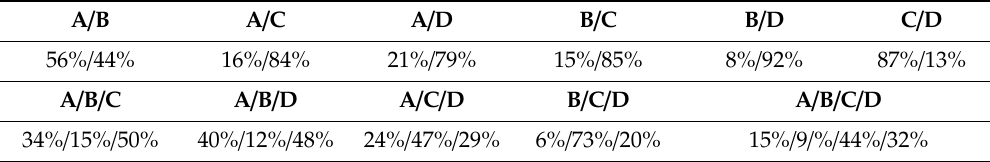
Table 11. Comparison of RI values using the ANN